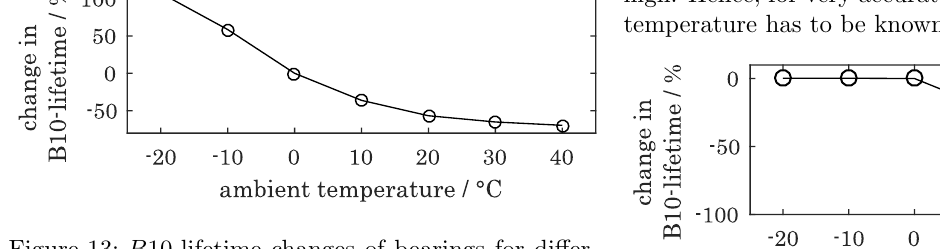
Figure 13: B 10-lifetime changes of bearings for differ- ent ambient temperatures,